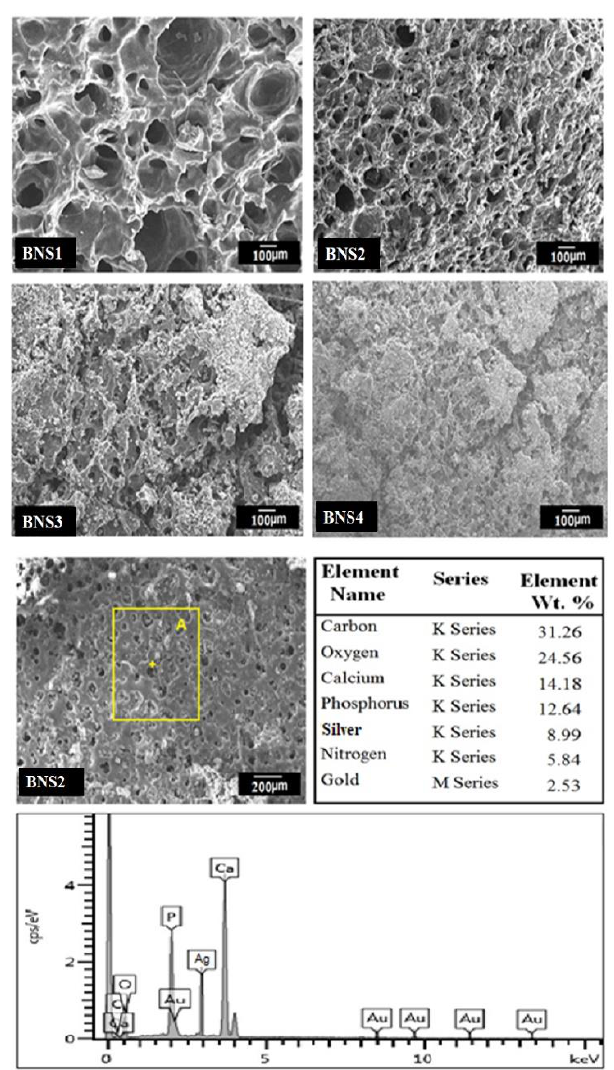
Figure 4. Scanning electron microscopy (SEM) images of BNS samples and elemental analysis of BNS3.